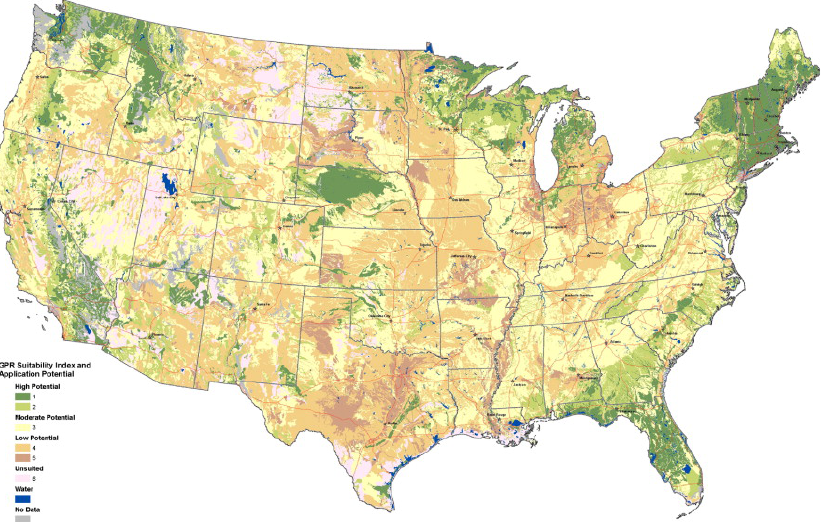
Figure 5. Soil suitability classification as inferred from GPR measurements, from green (high potential) to light red (unsuitable). Derived from [107].